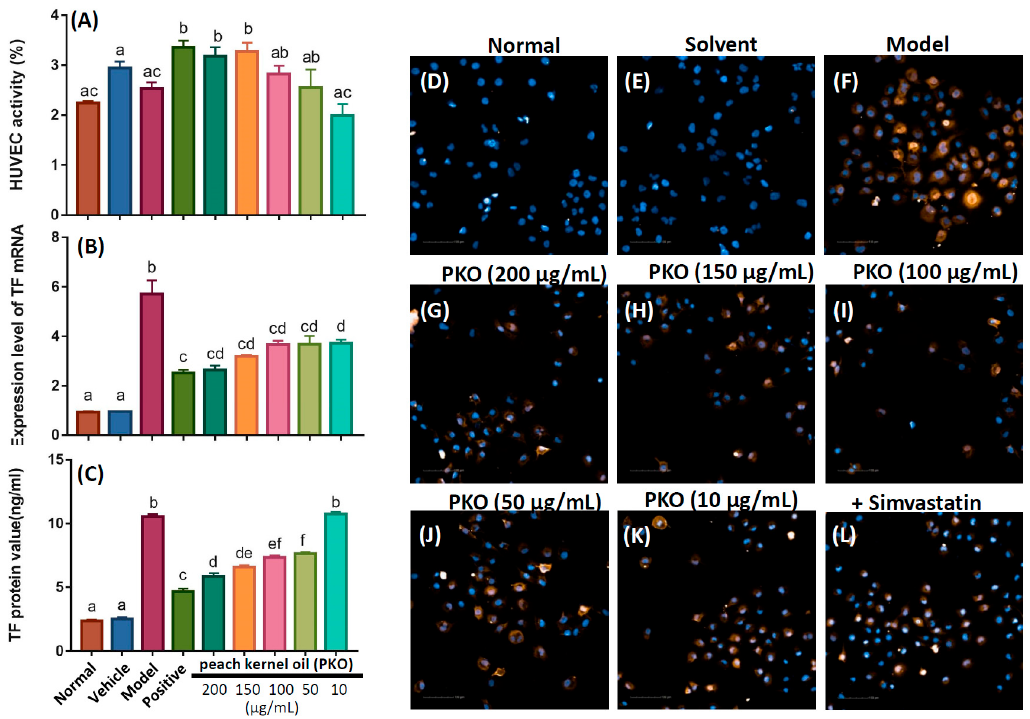
Figure 2. Cell viability, TF expression at mRNA and protein levels in HUVEC after treated with different concentration of peach kernel oil. No chemicals were added in the normal group. As a vehicle control, DMSO was added for evaluating the solvent effect. For the model group, TNF- α was added to the culture medium to stimulate TF protein expression. For the positive group, simvastatin was added to HUVEC to suppress the TF protein induction by TNF- α stimulation. After pretreating HUVEC with simvastatin or peach kernel oil, TNF- α protein was added to HUVEC culture medium to induce TF protein expression. ( A ) Cell viability of HUVEC after treated with different concentrations of peach kernel oil. The TF expression at mRNA ( B ) or protein ( C ) level in HUVEC after treated with different concentrations of peach kernel oil. ( D – L ) The expression of TF protein in HUVEC after treated with peach kernel oil detected by immunohistochemistry (yellow color). The cell nuclei were counterstained with DAPI. PKO stands for peach kernel oil. Different labels above columns in ( A – C ) indicate a significant difference tested by One-way ANOVA between different experimental groups with p < 0.01.